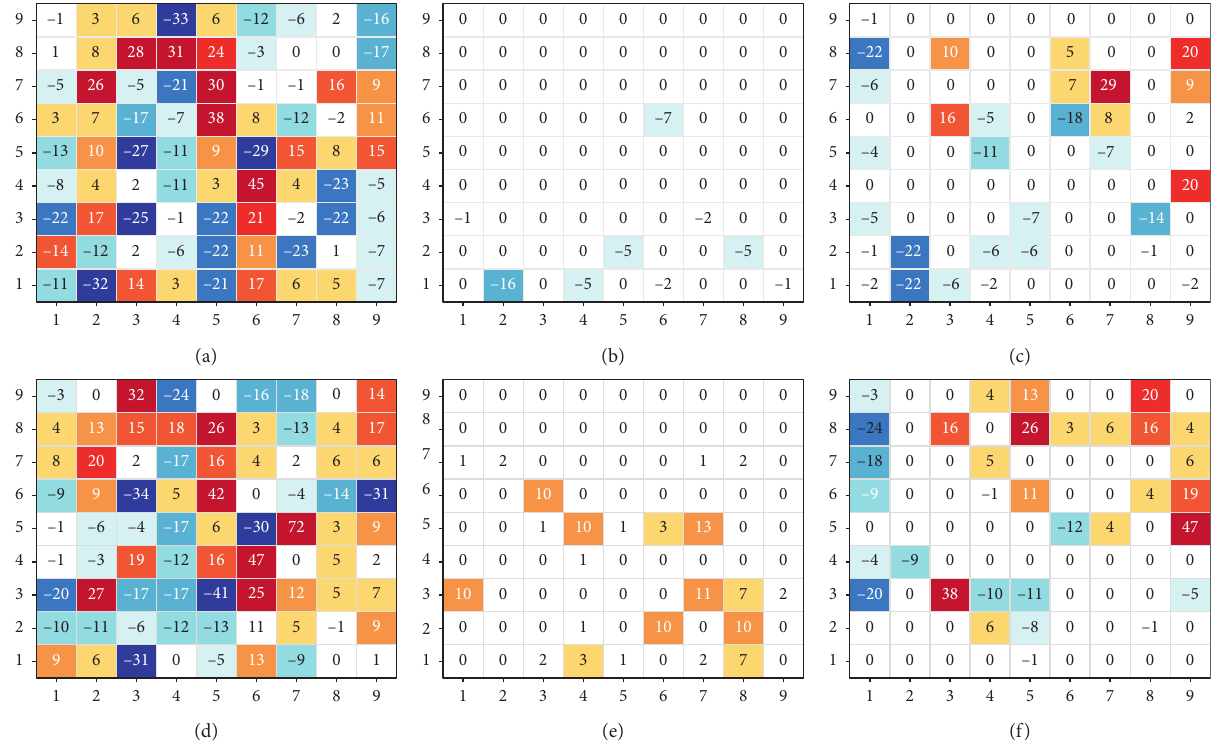
Figure 6: Dispatch result of the two models. (a) Unscheduled status at 9:00 on weekdays. (b) The result of (a) after the scheduling of model proposed in this paper. (c) The results of (a) after the scheduling of TLR model. (d) Unscheduled status at 21:00 on weekends. (e) The results of (d) after the scheduling of model proposed in this paper. (f) The results of (d) after the scheduling of TLR model.